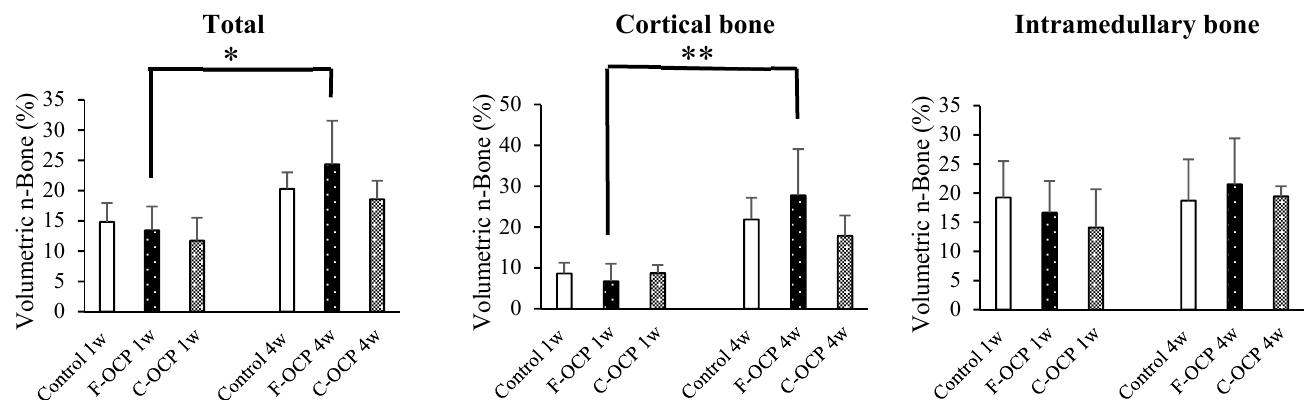
Figure 6. Micro-CT volumetric analysis of newly formed bone percentage of total, cortical, and intramedullary bone treated with no materials (control), F-OCP, and C-OCP at 1 week and 4 weeks post-implantation (** p < 0.01, * p < 0.05).